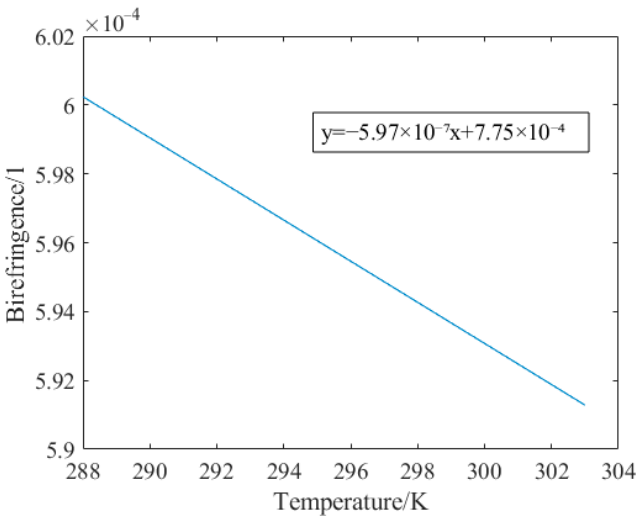
Figure 5. Simulation diagram of the relationship between birefringence and temperature of the